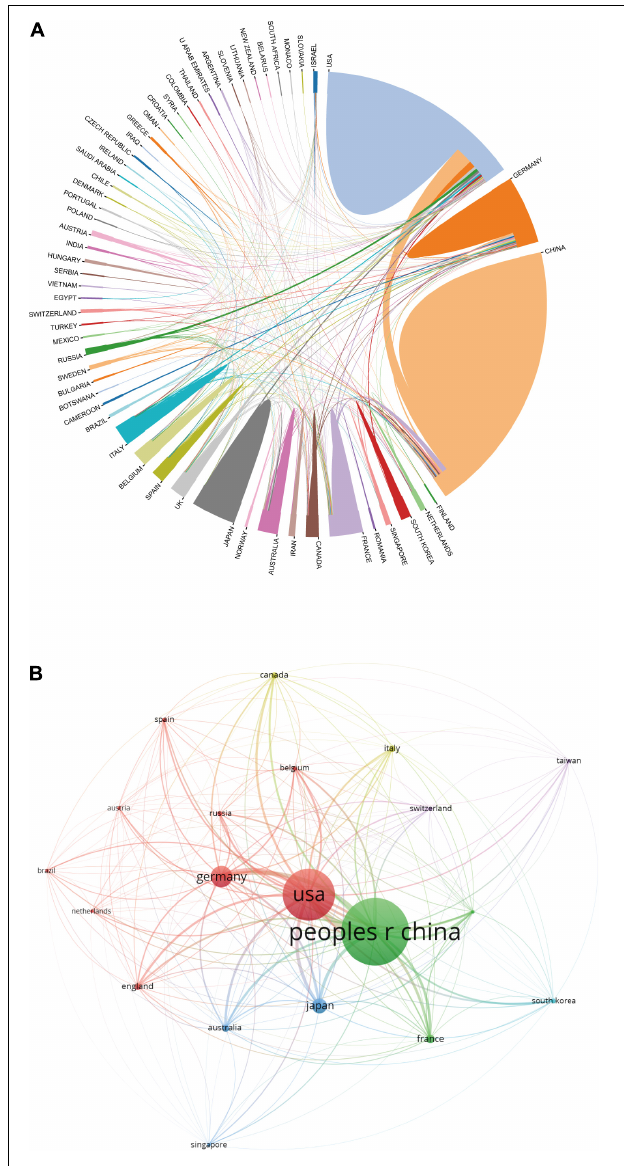
FIGURE 4 | (A) The cross-country collaborations visualization map. (B) The country citation network visualization map generated by VOS viewer